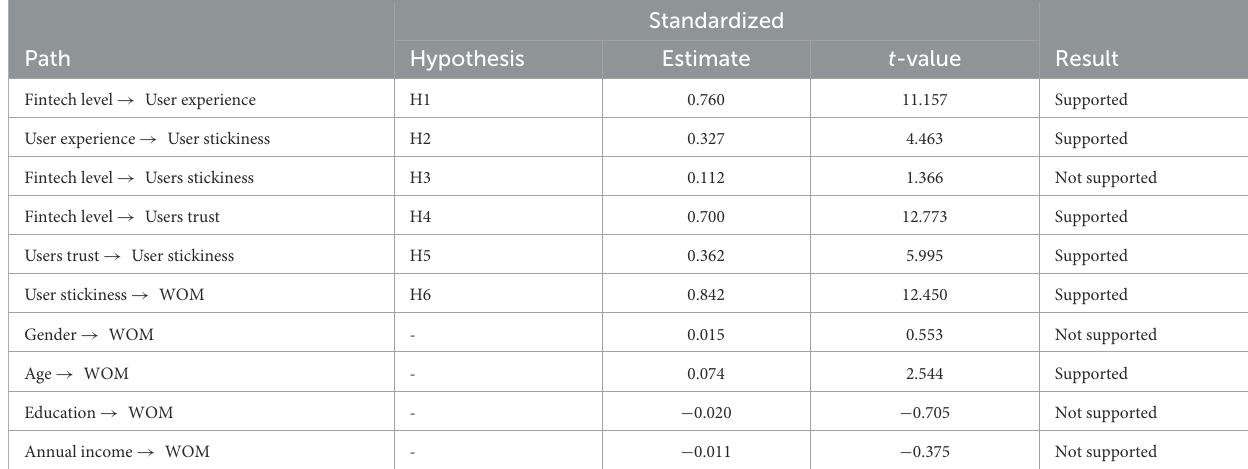
TABLE 5 Parameter estimates and hypotheses